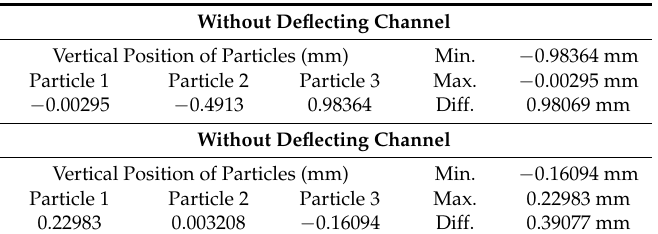
Table 1. The minimum required length at upper outlet for all particles to be captured: the data consider both configurations, namely in absence and presence of ancillary channel. Including a perpendicular channel reduces the length required.